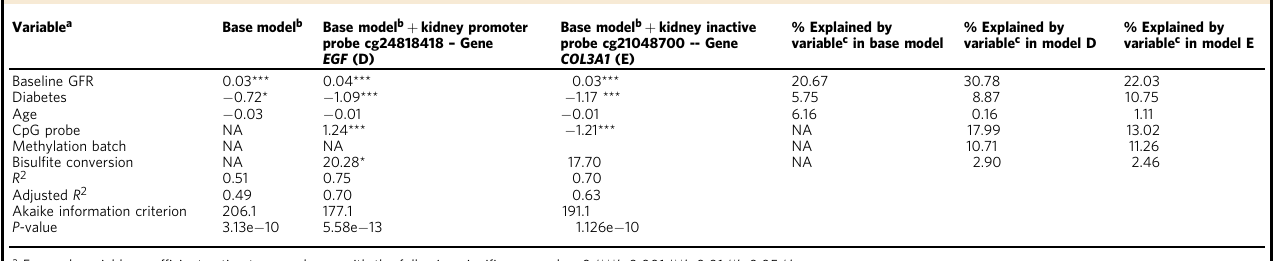
Table 5 Progression model with top probes associated with gene expression changes Variable